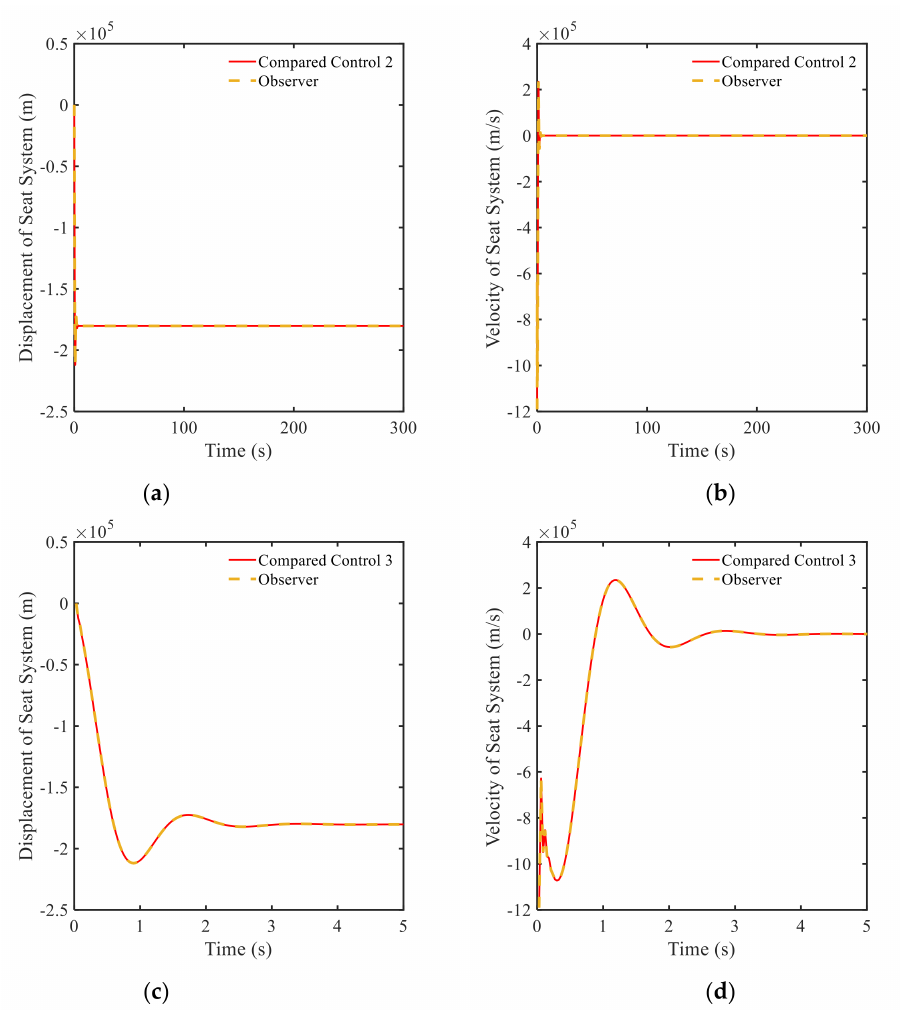
Figure 6. Displacement and velocity of seat system of the Compared Controller 2: ( a , b ) general view, ( c , d ) enlarged